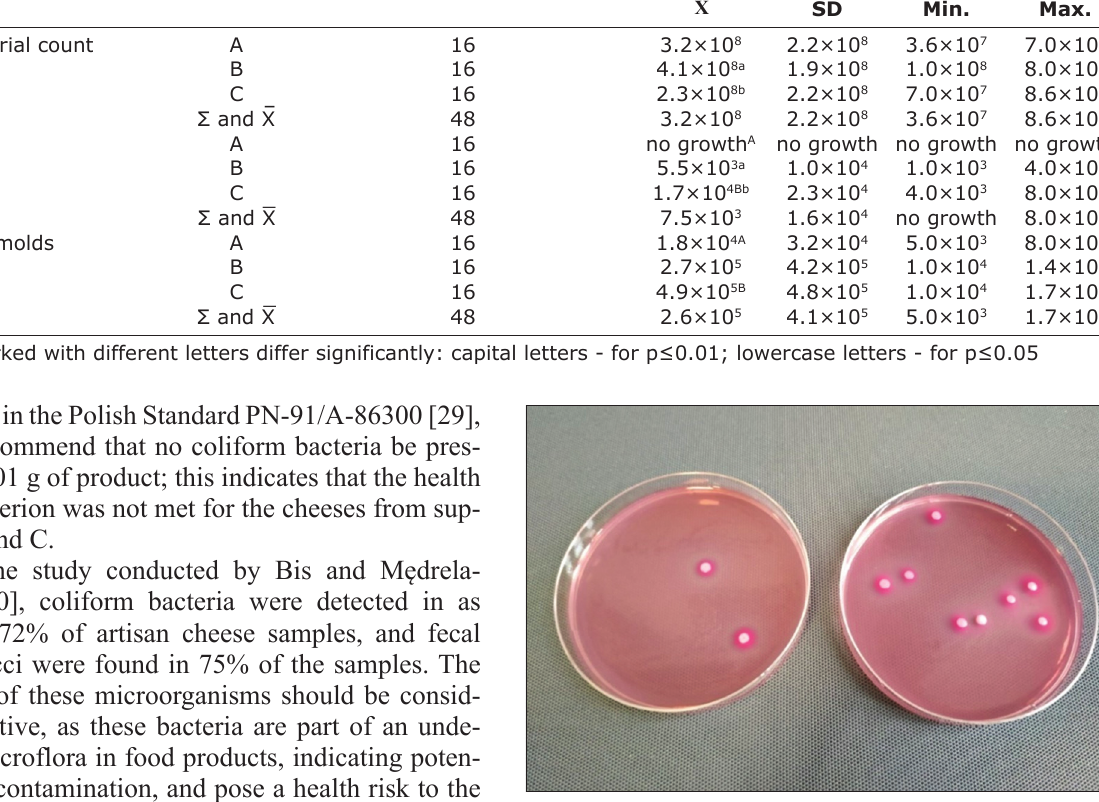
Figure-1: Colonies of bacteria present in curd cheese samples cultured on MacConkey medium ( own resources